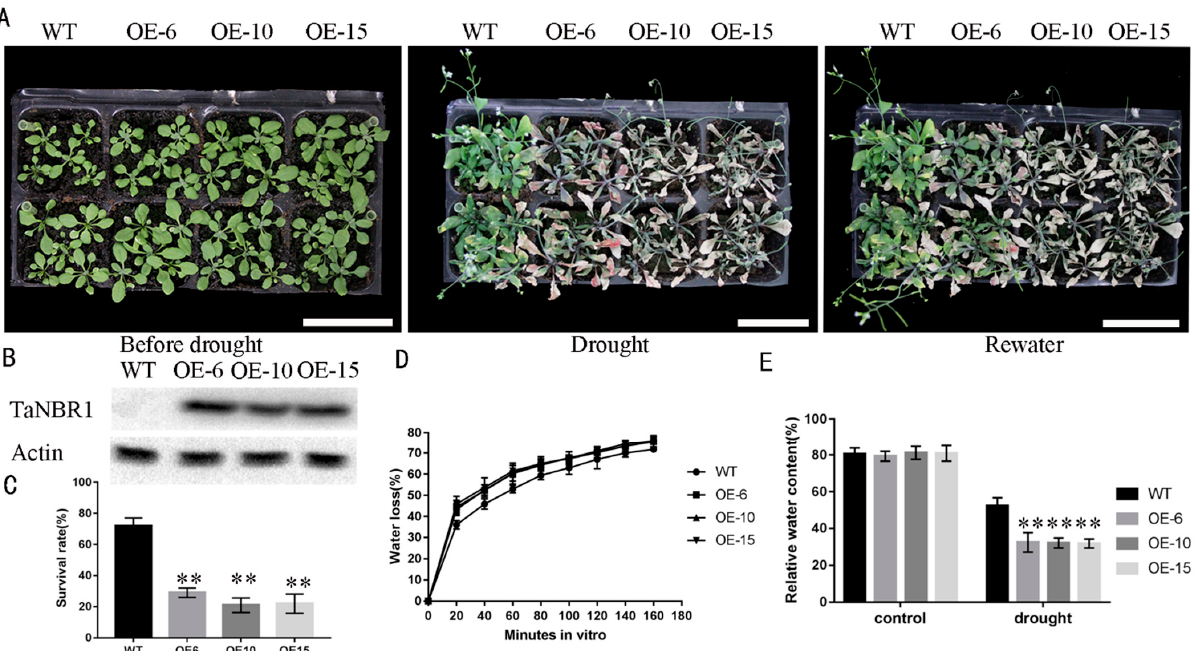
Figure 4. Phenotypes of the TaNBR1 -overexpressing transgenic plants and wild-type controls in Arabidopsis thaliana under drought conditions. ( A ) Drought treatment using 3-week-old plants. The wild-type controls and transgenic plants were grown in pots for 3 weeks and then subjected to drought treatment for 2 weeks. The plants were watered again, 3 days after the treatment. Bar = 6 cm. ( B ) The protein levels determined in the transgenic plants. 35S: TaNBR1 -EGFP was detected using an anti-GFP antibody and Actin was employed as the loading control detected with the anti- Actin antibody. ( C ) Survival rates of wild-type and TaNBR1 -overexpressing transgenic Arabidopsis plants after resuming watering. ( D ) Water loss by TaNBR1 overexpression transgenic and wild-type Arabidopsis plants in response to dehydration. ( E ) Relative water content in transgenic Arabidopsis plants and wild-type controls under normal conditions and drought stress. The data represent the mean ± standard deviation (n = 3), ** p ≤ 0.01.